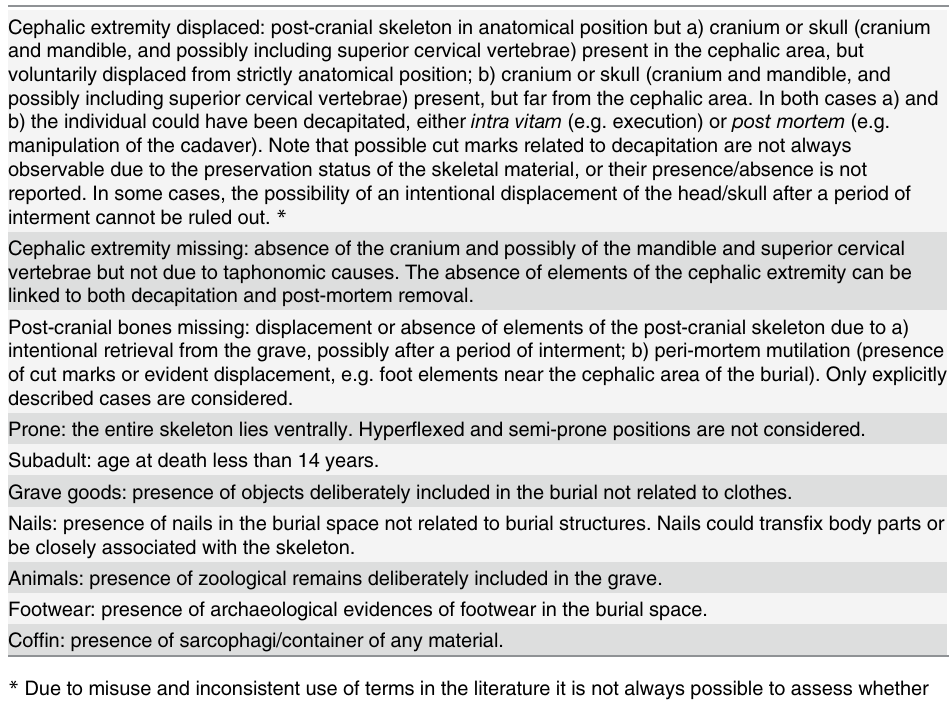
Table 1. Definition of the variables used in this